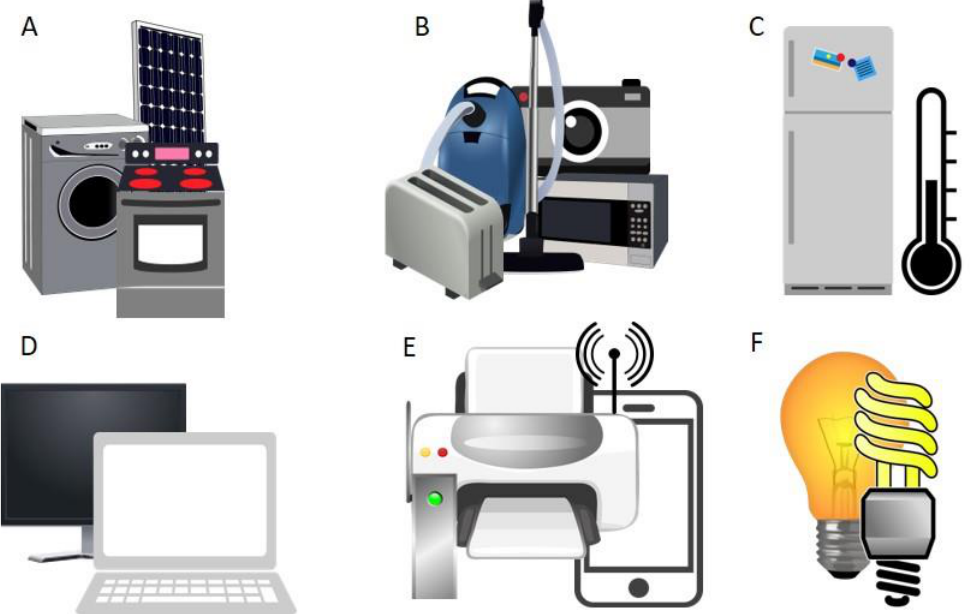
Figure 1. The six categories of e-waste: A) Large equipment, B) Small equipment, C) Temperature exchange equipment, D) Screens and monitors, E) Small information technology and telecommuni- cation equipment and F) Lamps [1].